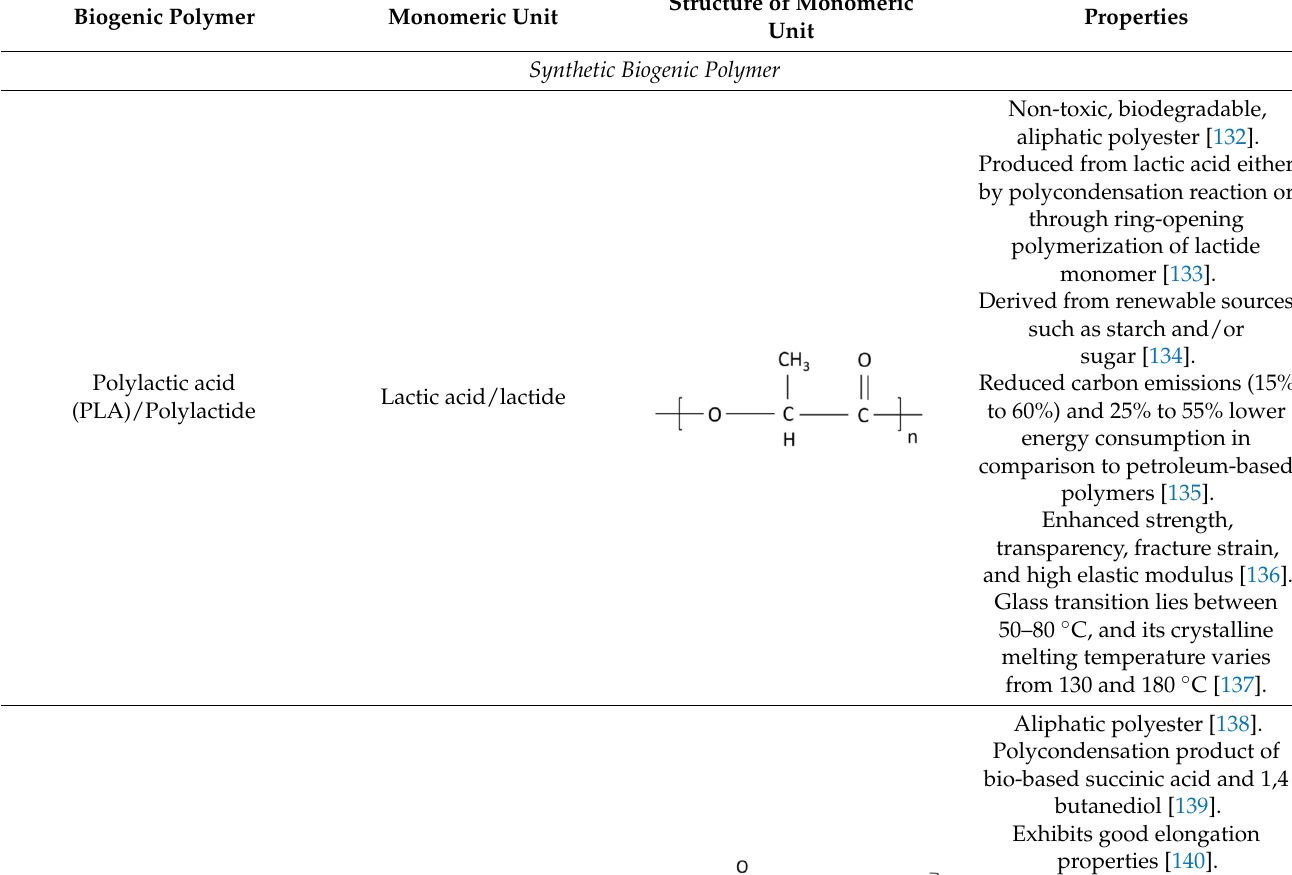
Table 2. Properties of synthetically-derived biogenic polymers used in food packaging.